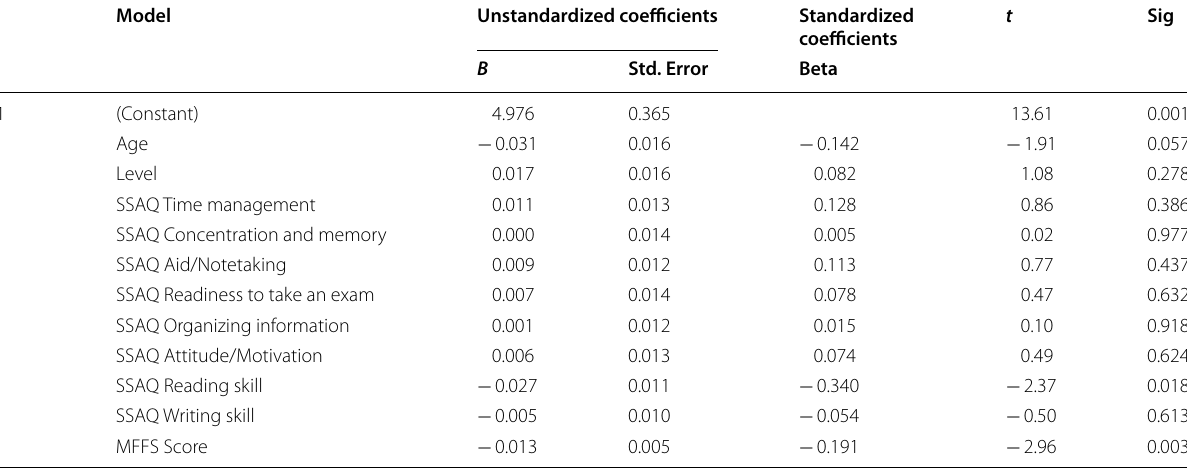
Dependent Variable: Exam Score. Model summary: Adjusted R SSAQ Study Skills Assessment Questionnaire; MFFS McMaster Family Function